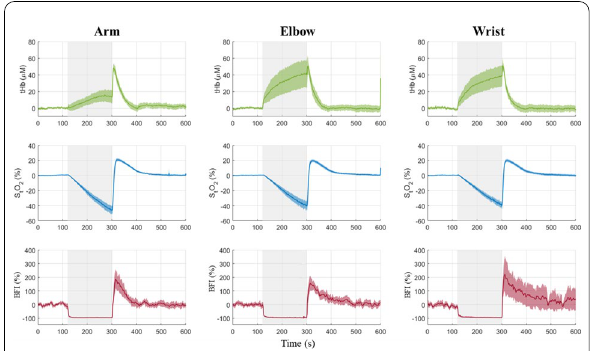
Fig.. 2: tHb, StO2 and BFI retrieved during VOT protocols on the thenar eminence, averaged among 19 subjects.Occlusion periods is in